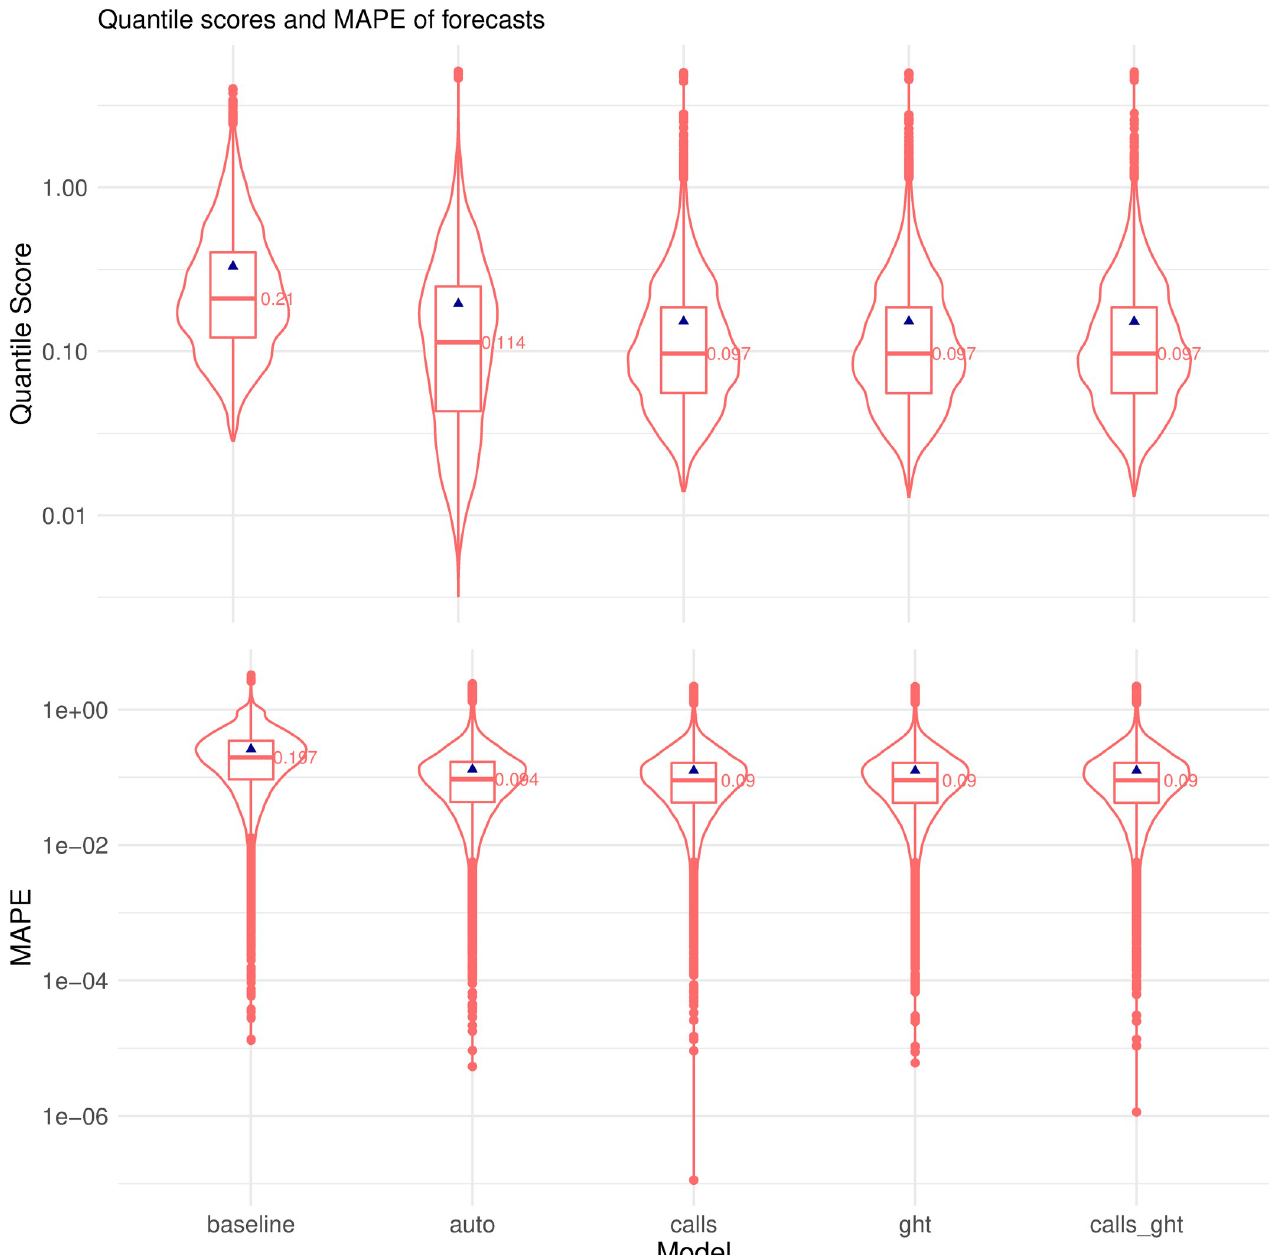
Fig 2. Boxplots of quantile scores and MAPE of forecasts from 5 models across all states and months. Blue points show mean estimate. p -value for Wilcoxon signed rank test on quantile scores: calls / ght =0.64; calls / calls_ght = 0.86; ght / calls_ght = 0.35. p -value for Wilcoxon signed rank test on MAPE: calls / calls_ght = 0.08; ght / calls_ght = 0.49. All other model pairs were statistically significant ( p < 1e-4).